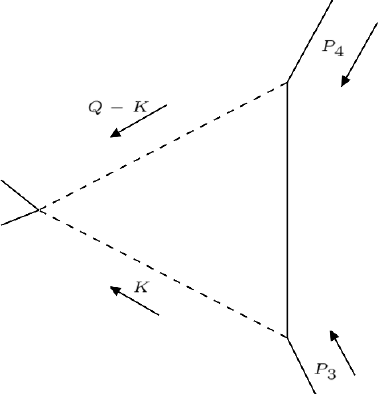
Figure 4. Alternative parametrization of the loop momenta in the scalar triangle